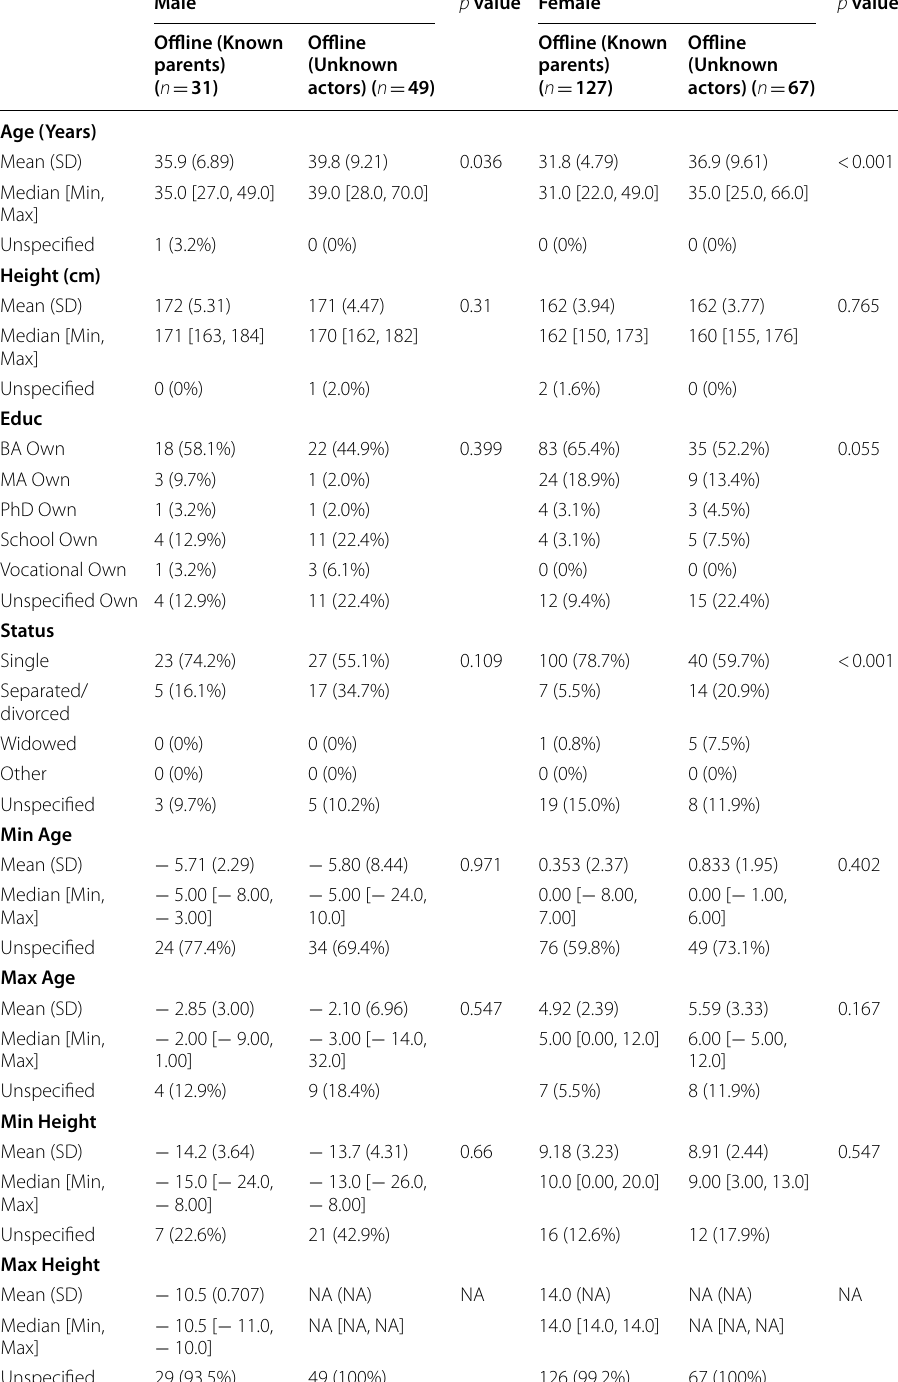
Table 5 Own Attributes and desired Partner Attributes for subsets of the offline sample, within each